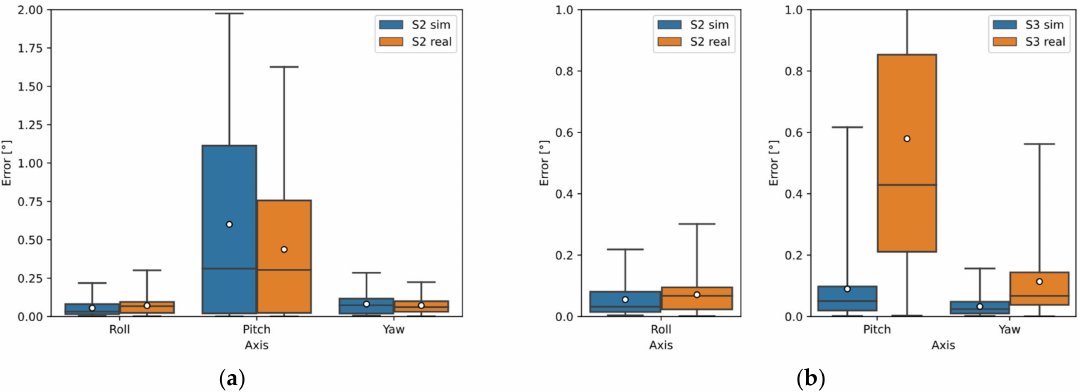
Figure 12. Comparison of results from simulation and real measurements of object C: ( a ) using one sensor—S2; ( b ) configuration of two sensors: S2 and S3-S2 (Roll detection) and S3 (Pitch and Yaw